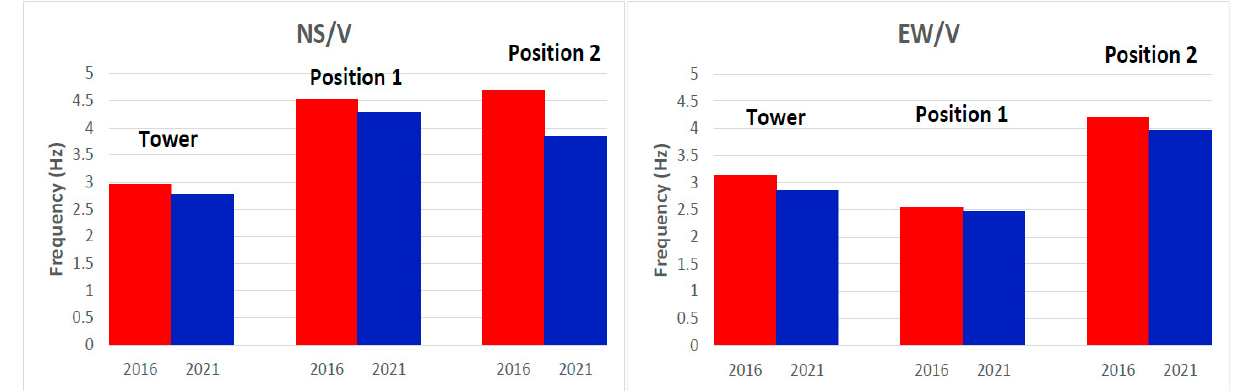
Figure 9. Bar charts showing change in fundamental frequency on the Castle’s tower, and 2nd floor positions 1 and 2.